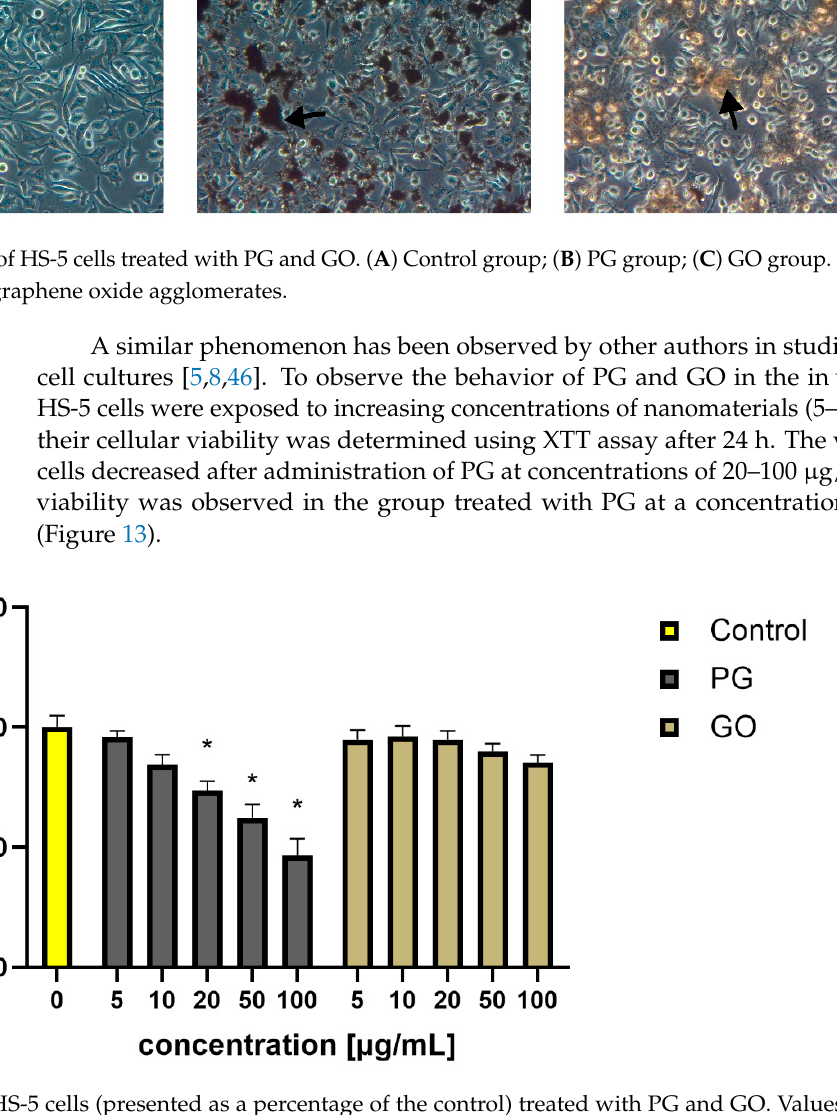
Figure 13. Viability of HS-5 cells (presented as a percentage of the control) treated with PG and GO. Values in the rows marked with an asterisk show statistically significant differences ( p < 0.05) as compared to the control assay. Abbreviations: C—control group (untreated cells); PG—pristine graphene; GO—graphene oxide.